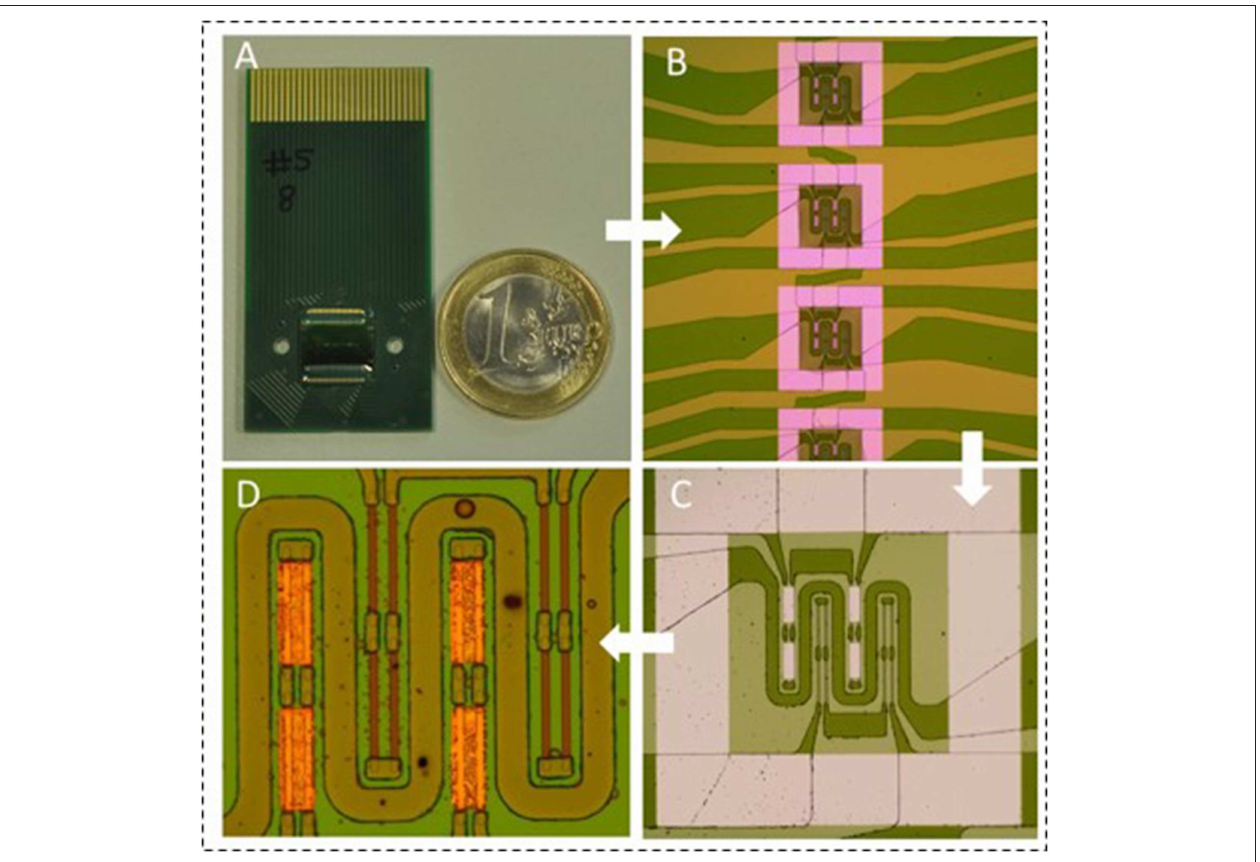
FIGURE 2 | (A) Picture of the magnetoresistive biochip developed by Magnomics S.A. (B) Zoom-in of some of the 15 sensing sites for automatic spotting of biorecognition probes. (C) Detail of one sensing site with 2 sensors. One active sensor (gold coated) and one reference sensor (bare). (D) Zoom-in of the sensors. Each sensor is composed of 8 sensor segments. The sensors are surrounded by a current line for magnetic attraction of the magnetic particles.